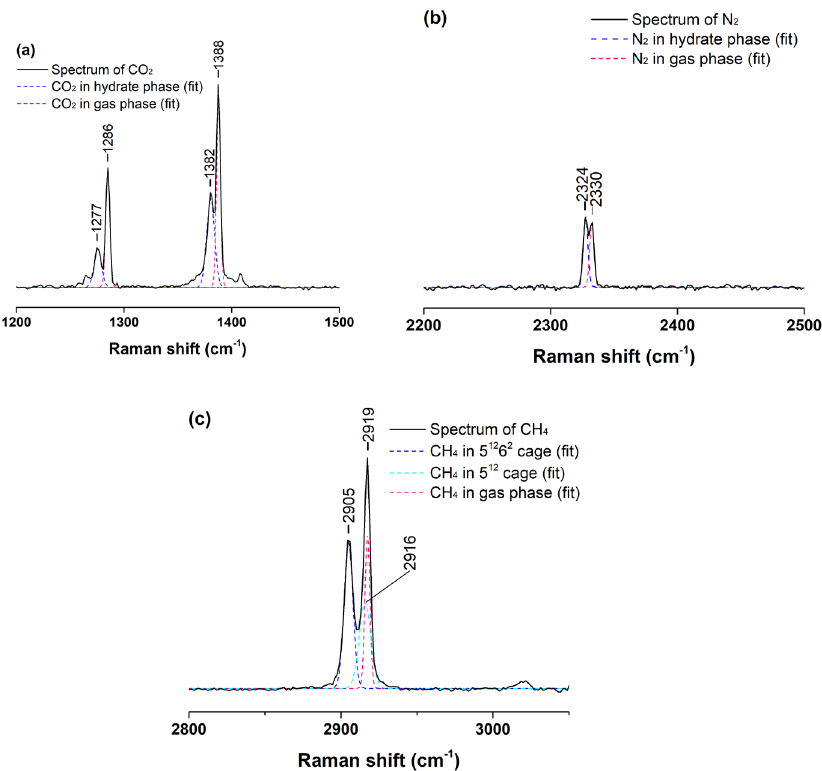
Figure 1. Typical spectra of CO 2 , N 2 , and CH 4 observed from in situ Raman measurements at 271.6 K. The characteristic peaks of CO 2 , N 2 , and CH 4 molecules in gas and hydrate phase are marked by dashed lines.